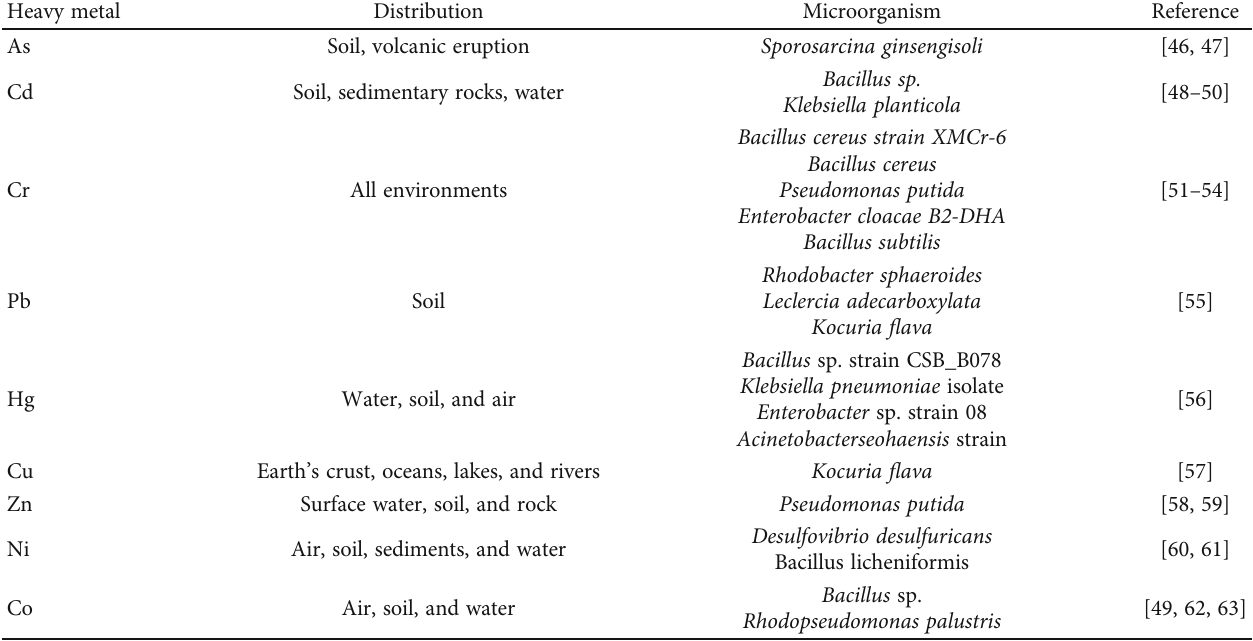
Table 2: Heavy metal distribution in environment and microorganisms involved in